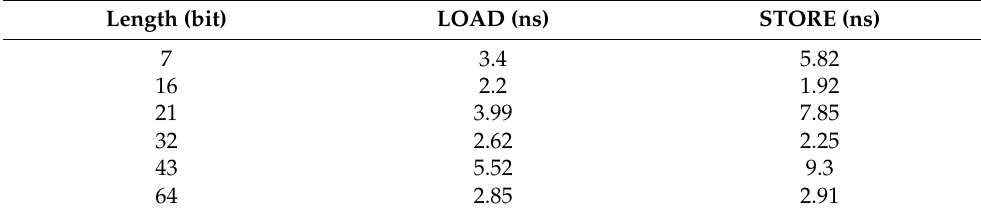
Table 5. Performance of loading and storing data of different lengths.